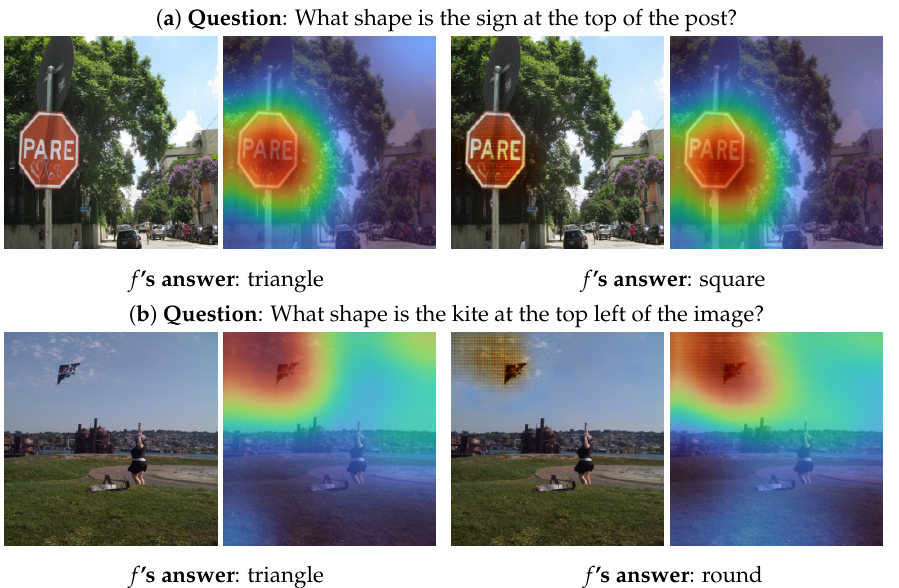
Figure 4. Examples of G ’s output for shape-based questions from the VQAv1 [3] validation set. Left: original image I and the corresponding attention map M . Right: Generated counterfactual image I (cid:48) and the corresponding attention map M (cid:48) .